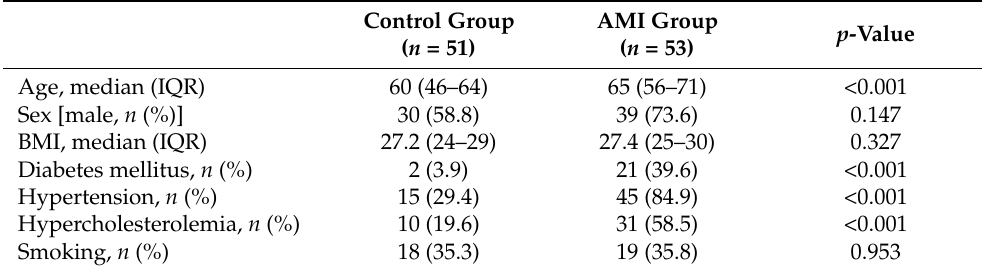
Table 1. Baseline